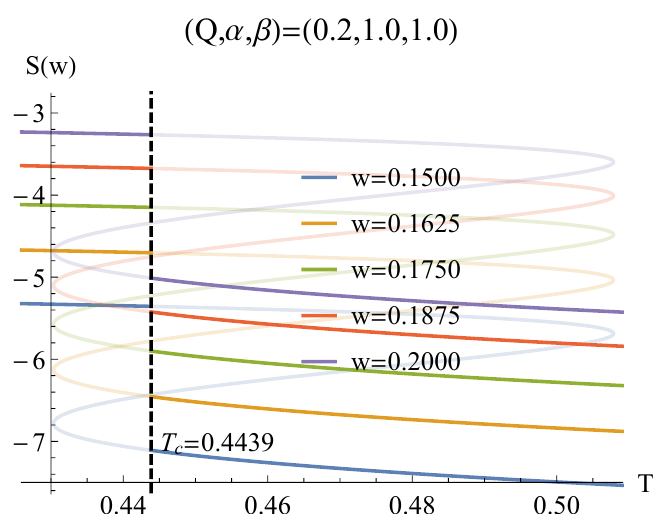
Figure 3 . HEE vs. T at several small widths, where the lighter segments correspond to the metastable regions. The red dashed horizontal line represents the critical temperature T c = 0 . 4439 of the first-order phase transition.